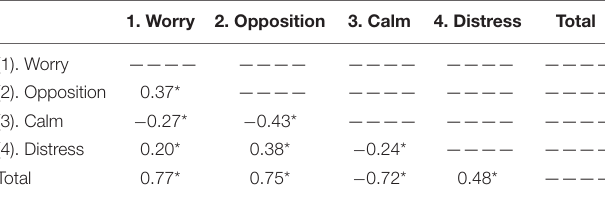
TABLE 3 | Correlation matrix among factors and with CSAS-P total